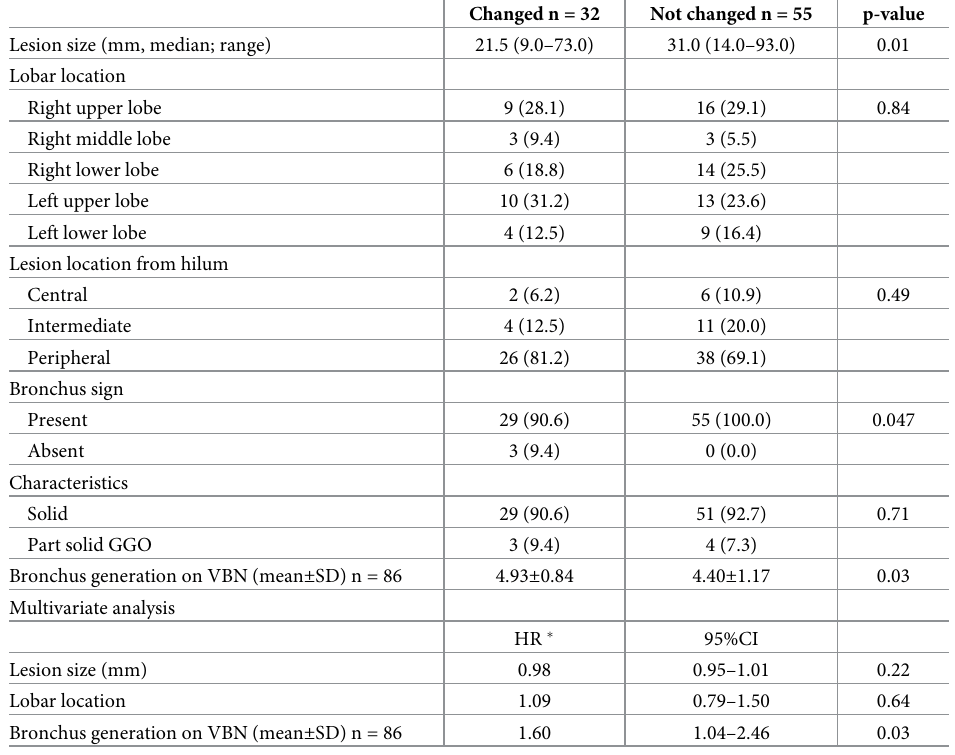
Table 4. Factors associated with change to a thinner